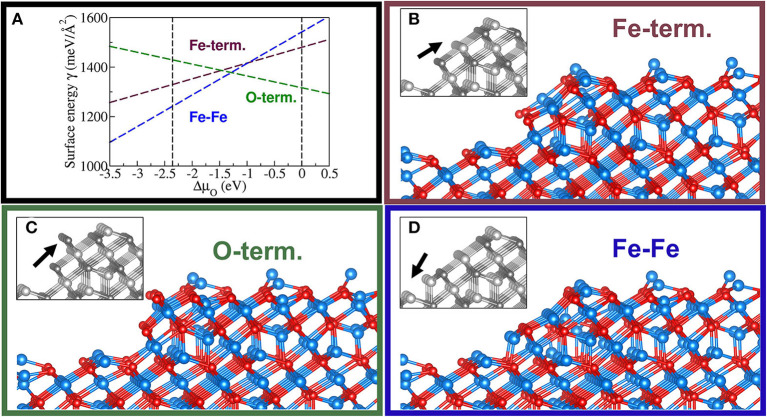
Stability diagram for three terminations of a step of one-repeat unit (i.e., six atomic layers) in height for the Fetet1-terminated Fe3O4(111) surface (A). Additionally, a Feoct-terminated facet (B), an O-term. facet (C), and a supposedly unstable step having two consecutive low coordinated Fe-rows (D) are shown. The black arrow in the gray-colored inset, representing the unrelaxed structure, indicates these distinct features of the step models. Same color code as in Figure 3.